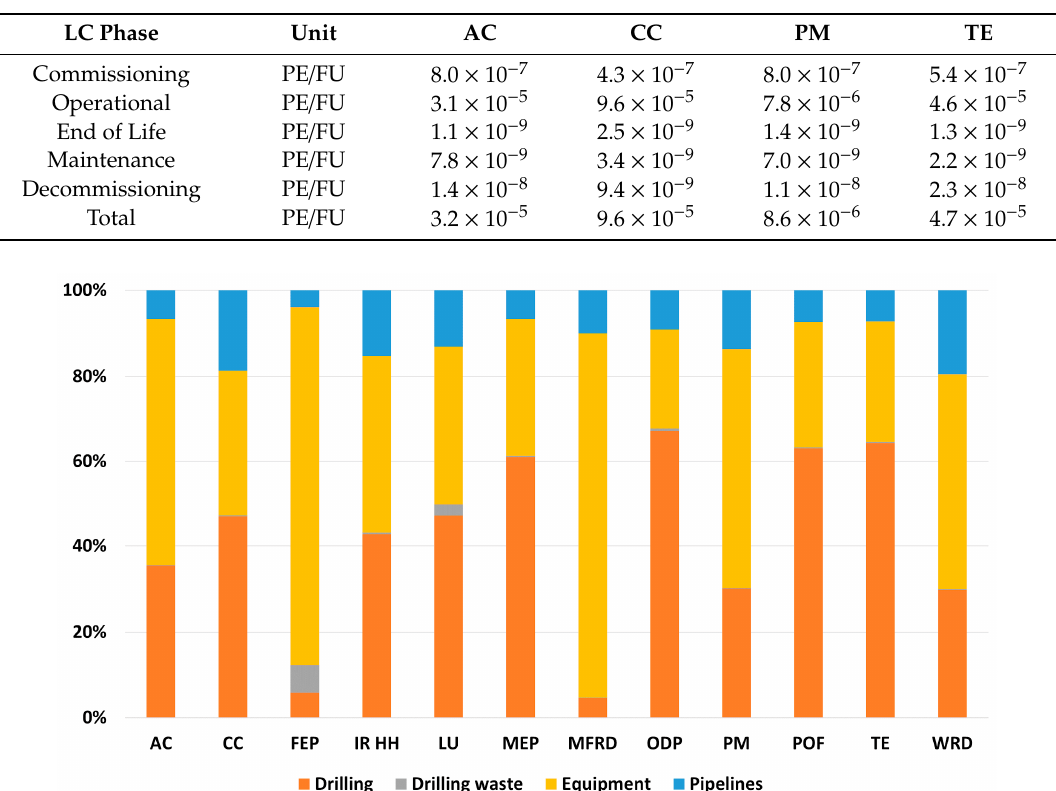
Table 8. Contribution of LC phases to the most impacting categories: AC, CC, PM and terrestrial eutrophication (TE). Impacts are reported as person equivalent (PE) per functional unit (FU). Complete information can be found in the Supplementary Materials.